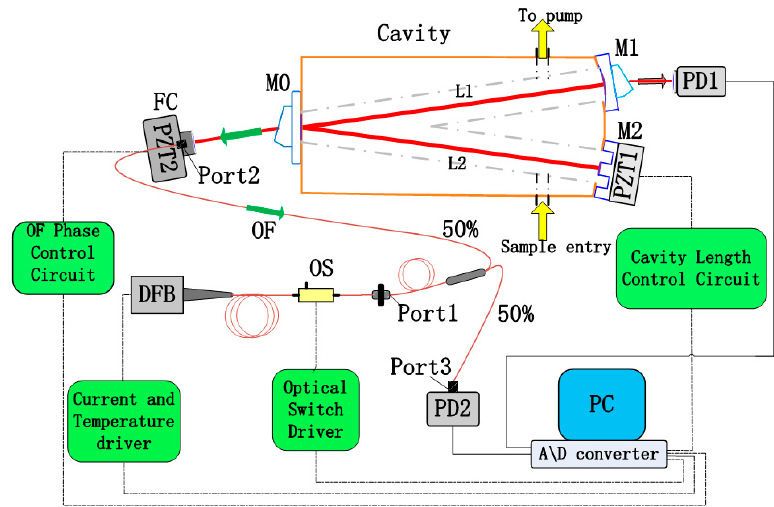
Figure 1. Scheme of the fibered OF-CEAS experimental setup with a fibered DFB laser diode. The laser-cavity path is constructed with fiber components, and the distance can be finely controlled by sub-wavelength displacements of the PZT2, which is connected to the PC to actively control the feedback phase. DFB: distributed feedback; M0-M2: mirrors; PD: photodetector; PZT: piezoelectric